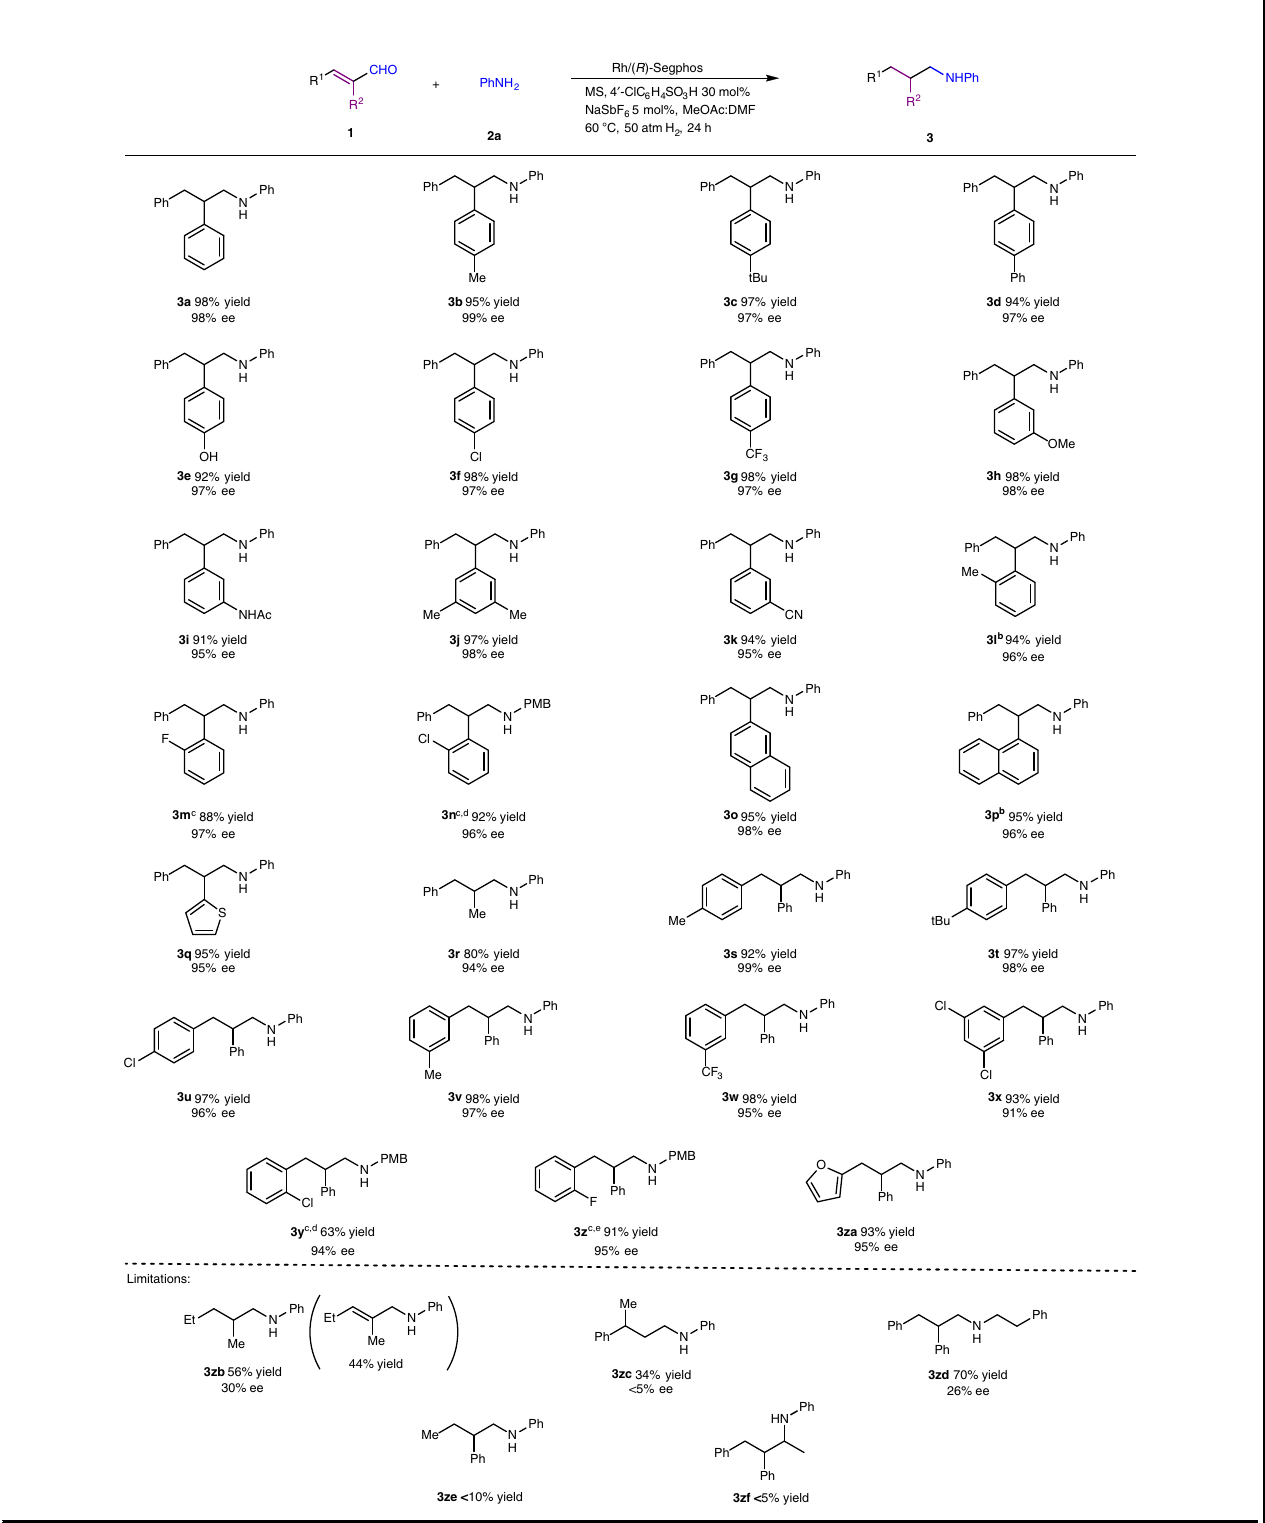
Table 2 Investigation of α , β -unsaturated aldehyde scope.